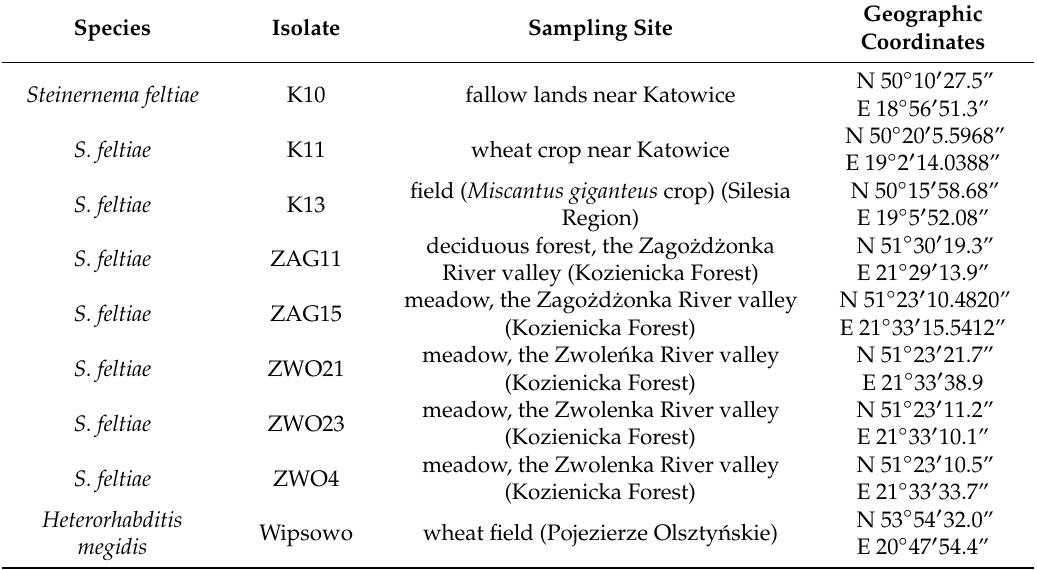
Table 1. Isolates used in